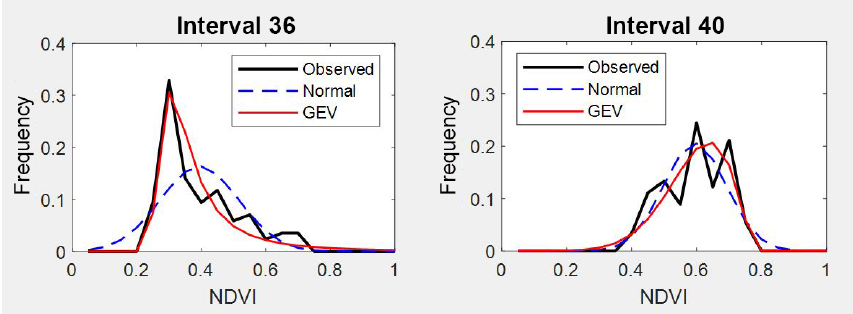
Figure 7. Comparison between observed NDVI frequency, GEV and normal probability density functions on two different times. Intervals 36 and 41 are examples for autumn.